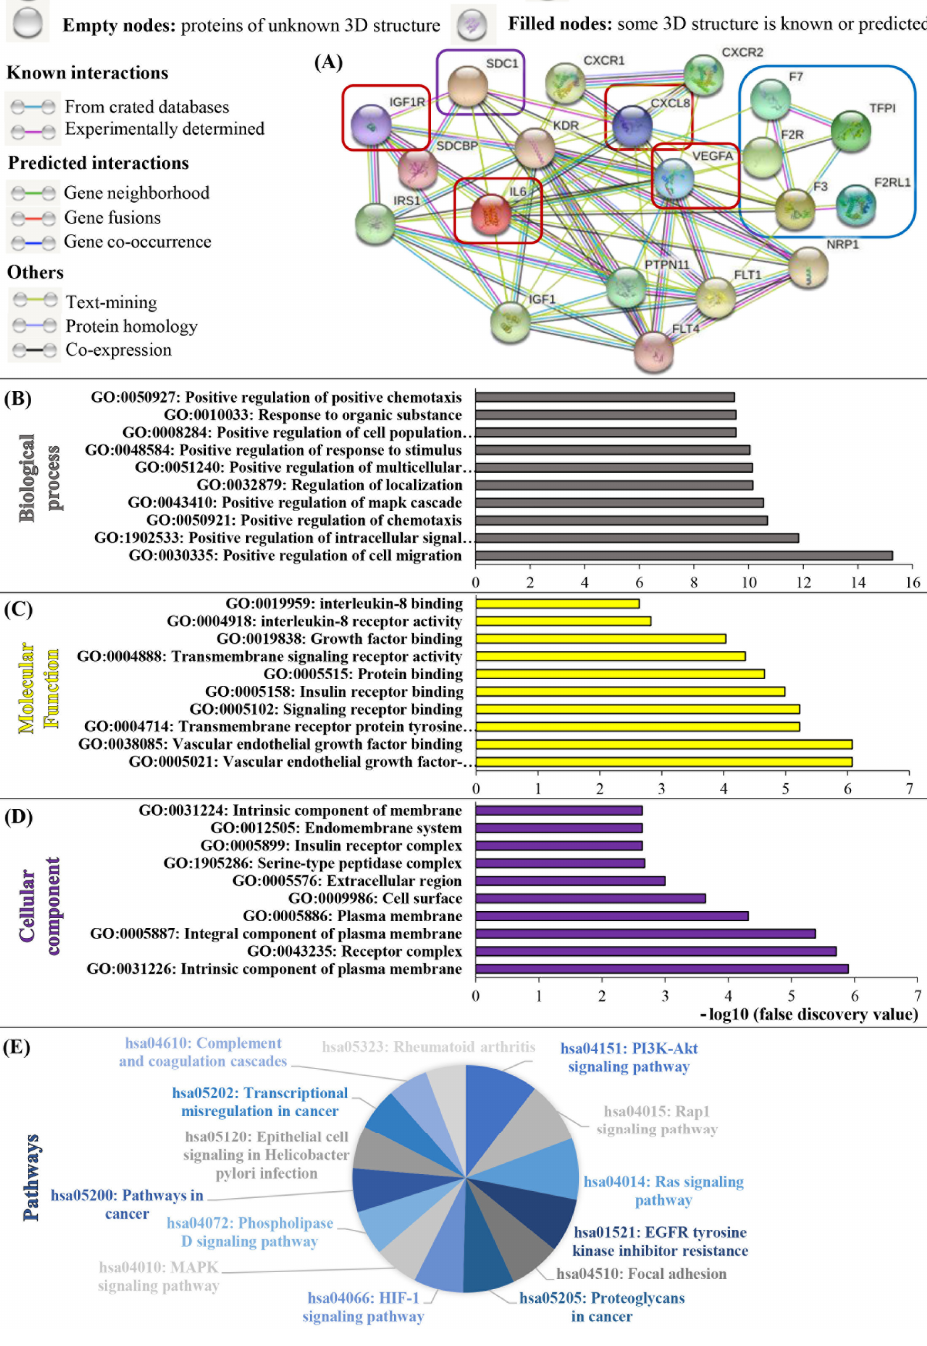
Figure 6. STRING analysis, revealing interactions between Sdc-1, the TF pathway, and cancer-related processes. Using the STRING database (http://string-db.org/ (accessed on 1 September 2022)), the protein–protein interaction network of Sdc-1 and TF pathway-related genes with respect to IL6, IL8, VEGF, and IGF-1R was determined via STRING analysis. ( A ) Interaction network of Sdc-1 (violet box), TF-pathway-related genes (TF, F7, F2R, F2RL1, and TFPI) (blue box) and IL6, IL8, VEGF, and IGF-1R (red boxes). Gene ontology (GO) analysis: ( B ) KEGG pathway analysis, ( C ) biological process, ( D ) molecular function, and ( E ) cellular components. The graphs for biological process (gray), molecular functions (yellow), and cellular components (violet), and the pie chart for KEGG pathways revealed the ten most significant GO keywords ( p < 0.05). The log10 transformation was used to present the top 10 values. Tables S4–S6 contain further information.